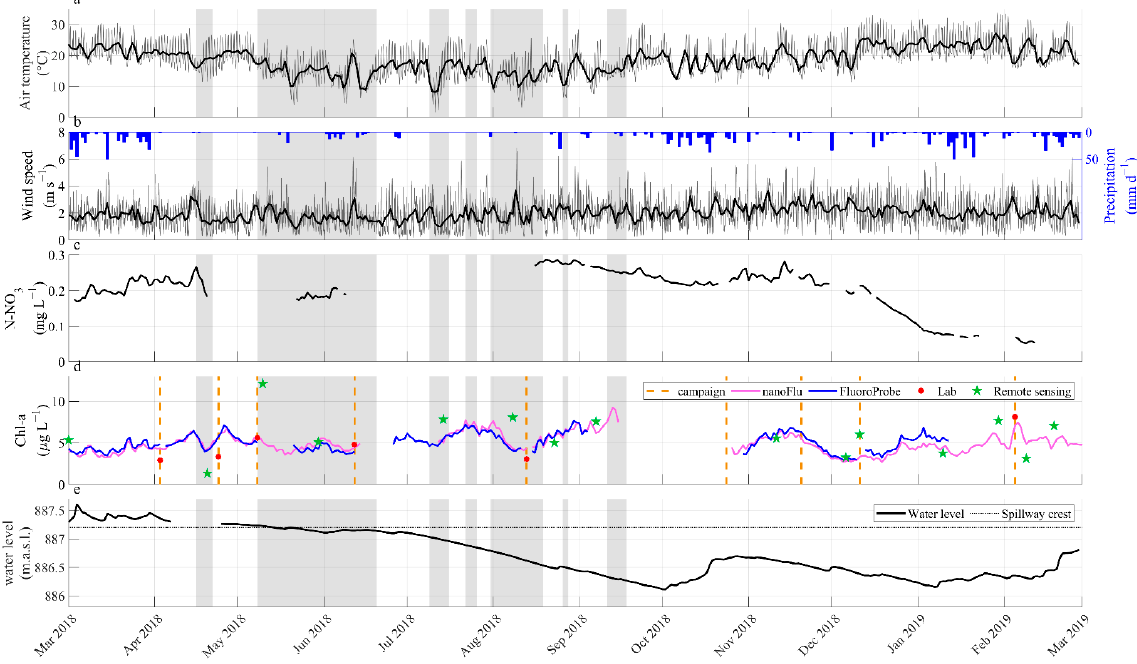
Figure 2. ( a ) Time series of daily mean air temperature. ( b ) Time series of wind speed (left y -axis, the gray fine line shows hourly averaged values and the black thick line shows daily means) and daily mean precipitation in mm d − 1 (right y -axis) adopted from [26,34]. ( c ) Time series of N-NO 3 measured by the OPUS sensor. ( d ) Time series of chla measured by sensors with daily resolution (nanoFlu (pink) and FluoroProbe (blue) solid lines), laboratorial analysis (red symbols), and remote sensing (green symbols). The dashed vertical orange lines mark the days where field campaigns were performed. Gray background color marks periods of vertical mixing in all panels; during the remaining time, the reservoir was thermally stratified (adopted from Ishikawa, Bleninger, and Lorke [34]). ( e ) Time series of water level in meters above sea level (m.a.s.l.) in black thick line, the dotted line shows the crest of the spillway.